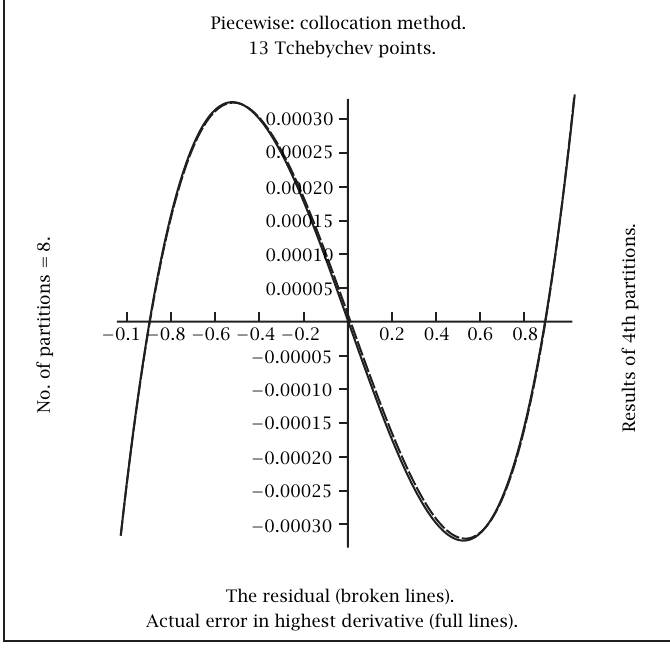
Piecewise: collocation method. 13 Tchebychev